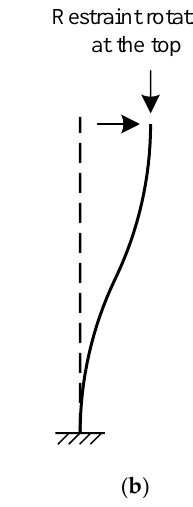
Figure 4. Pushover modes of the central column: ( a ) Mode 1; ( b ) Mode